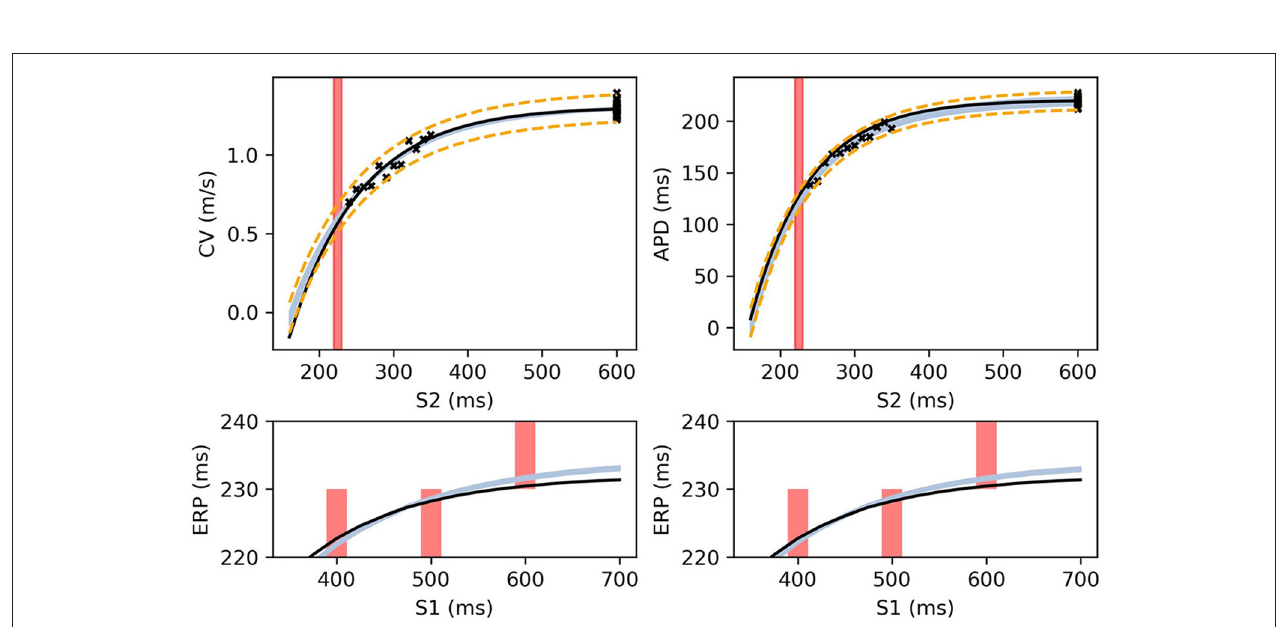
FIGURE 8 | The RCE prediction from maximum a posteriori (MAP) parameter estimates given noisy measurements for (left) CV(S2) and ERP(S1), (right) APD(S2) and ERP(S1), shown as light shaded regions representing RCE 95% confidence intervals. The orange dashed curves show these intervals including the observation error, also learned from MAP fitting. The noisy S2 restitution data are shown as crosses, while the red shaded bars represent observed intervals containing ERP: (top): bars horizontally span ERP(S1:600) interval; (bottom) bars vertically span ERP(S1) interval for several S1. The solid black lines in all plots represent the corresponding ground truth